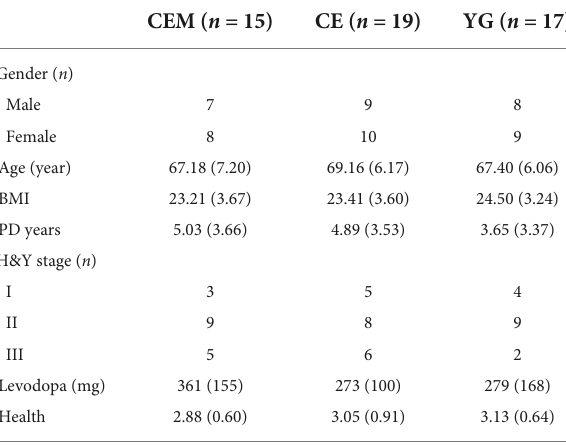
TABLE 1 Demographic information of participants among the Yang-ge dancing, conventional exercise, and conventional exercise plus music groups.